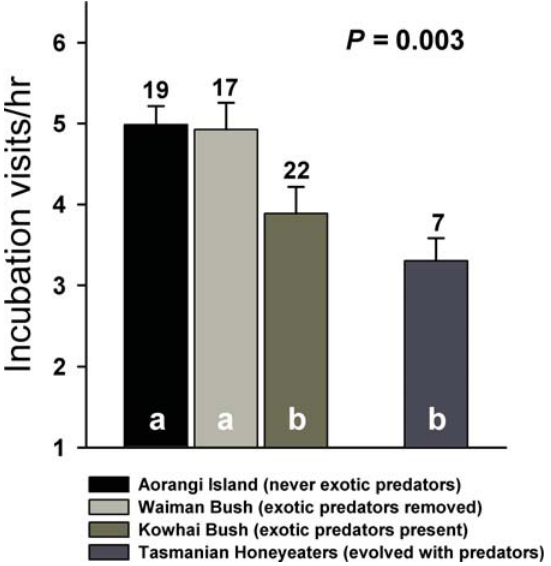
Figure 2. The number of parental visits to the nest per hour during incubation for bellbirds on Aorangi Island, where exotic predators were never introduced, for bellbirds in Waiman Bush, where exotic predators were removed, for bellbirds in Kowhai Bush, where all exotic predators are present, and for honeyeaters in Tasmania, which evolved with a range of native mammalian predators. Shared letters within bars denote non- significant (i.e., p . 0.05) statistical differences based on LSD tests. Figures above bars are the number of nests filmed in each study site.